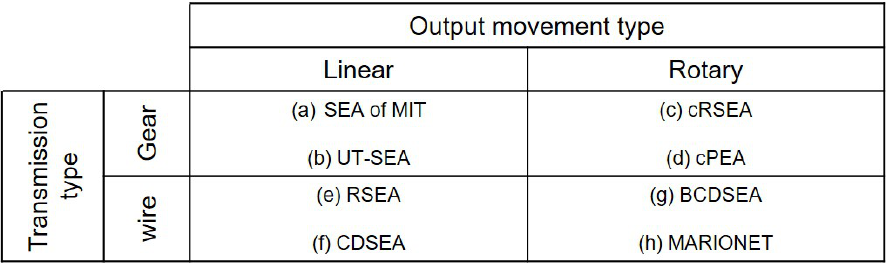
Figure 1. The SEAs which are categorized in terms of the types of transmission and the types of motion. ( a ) Series Elastic Actuator [2], ( b ) University of Texas-Series Elastic Actuator [13], ( c ) compact Rotary Series Elastic Actuator [14], ( d ) compact Planetary-geared Elastic Actuator [15], ( e ) Rotary Series Elastic Actuator [16], ( f ) Cable Driven Series Elastic Actuator [17], ( g ) Bowden Cable Driven Series Elastic Actuator [18] and ( h ) Series elastic actuator of MARIONET